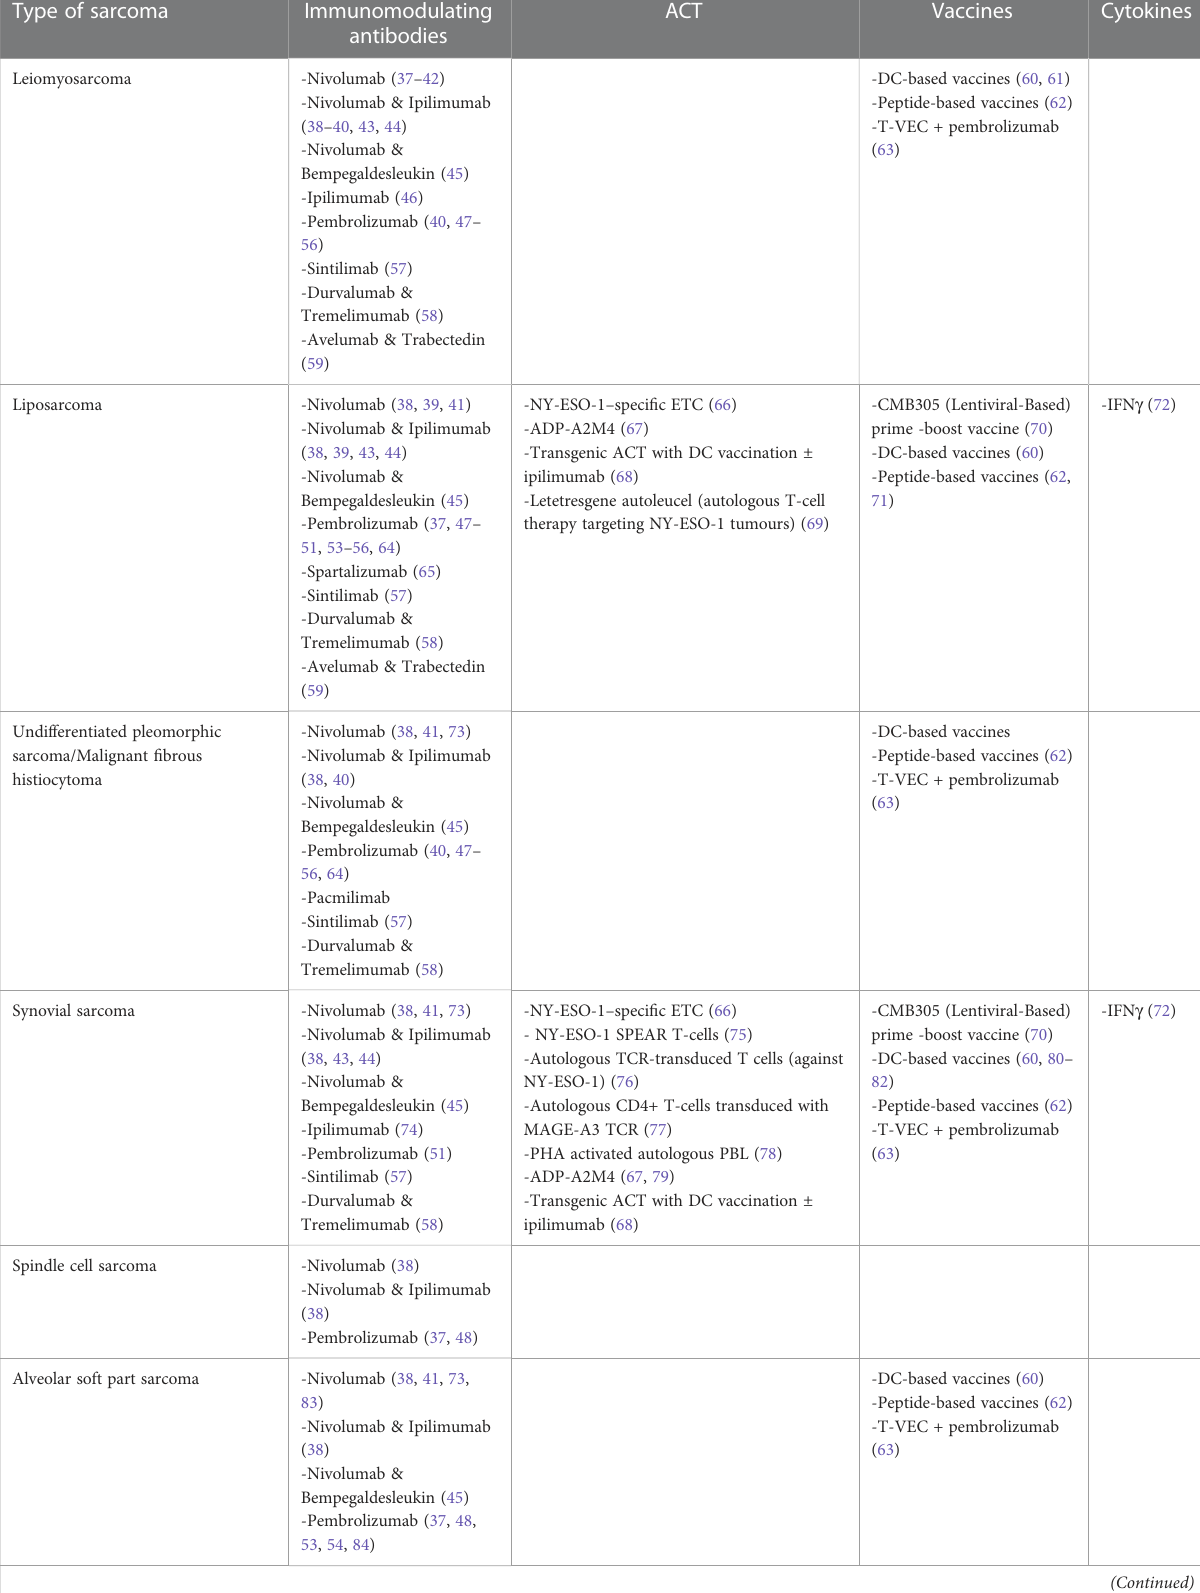
TABLE 1 Different types of immunotherapies that have been investigated in selected histological types of